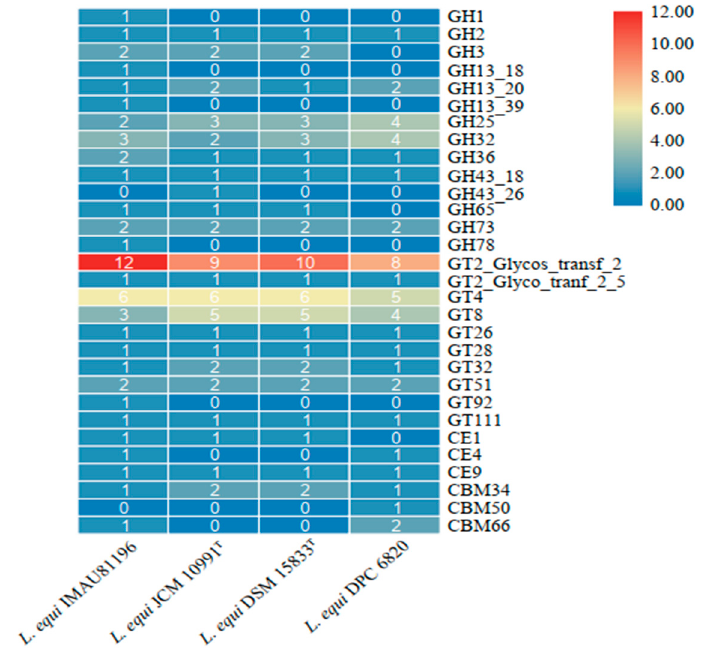
Figure 5. Gene number of CAZymes in four strains of L. equi .